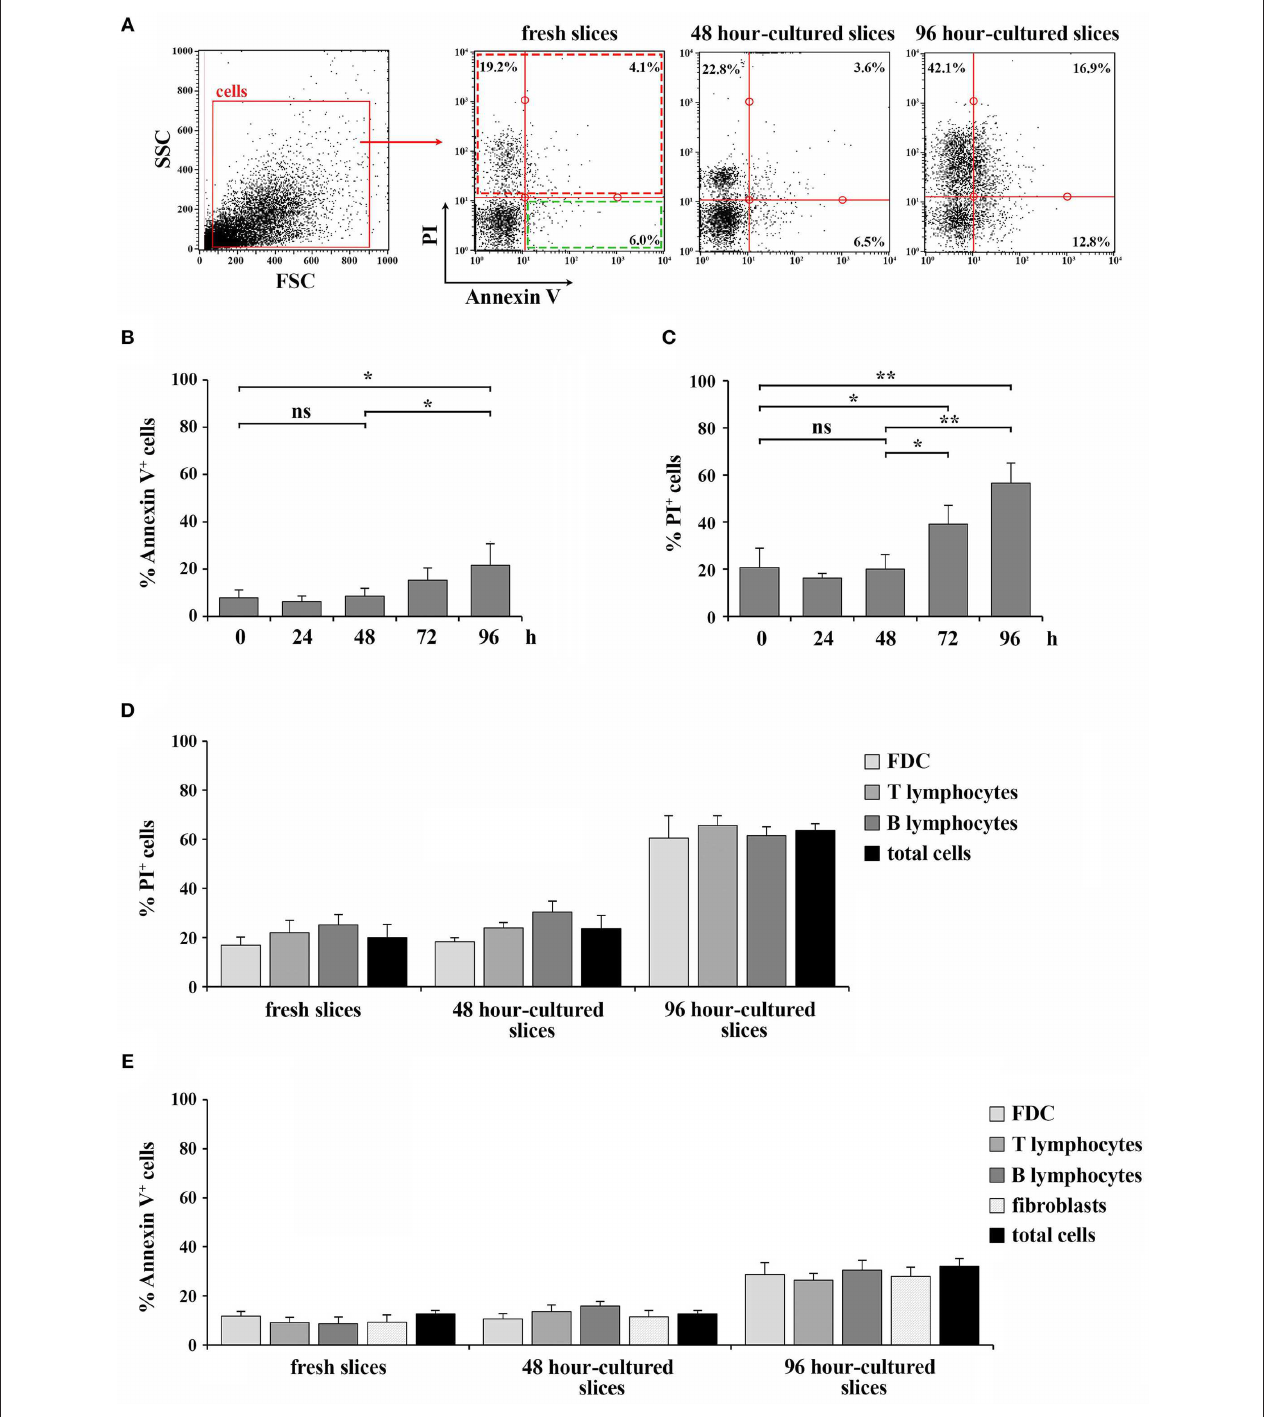
FIGURE 4 | 48 h-culture does not selectively affect the viability of cell types within spleen slices. (A–C) Flow cytometric analysis of the percentage of Annexin V + cells (B) or PI + cells (C) in spleen slices disgregated either immediately after cutting (fresh slices, 0) or after in vitro culturing for 24, 48, 72, and 96h, and stained with Annexin V FITC and with 10ng/ml PI. The data are presented as the percentage of either Annexin V + or PI + cells over total cells ( n = 3). Representative flow cytometric plots are shown in (A) . (D) Flow cytometric analysis of spleen slices either immediately after cutting (fresh slices) or cultured in vitro for 48h (48 h-cultured), disgregated, labeled for CD3, CD19, or FDC marker and with 10ng/ml PI. (E) Flow cytometric analysis of spleen slices either immediately after cutting (fresh slices) or cultured in vitro for 48h (48 h-cultured), disgregated, labeled for CD3, CD19, FDC, or ER-TR7 and Annexin V PE. The data are presented as the percentage of either PI + (D) or Annexin V + (E) cells over CD3 + , CD19 + , FDC + , or ER-TR7 + cells ( n = 4). Mean ± SD. Student’s t- test; ** p ≤ 0.01; * p ≤ 0.05.